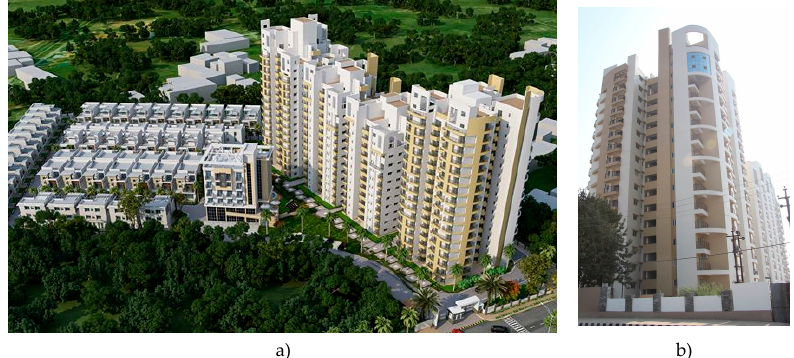
Figure 2. Global overview of the high-rise structure under study: ( a ) location of the houses and the high-rise buildings; and ( b ) front view. The tower is composed by RC frames filled with masonry infill walls made with solid clay bricks aligned according to the longitudinal and transverse direction and two stiff RC cores destined to the elevator boxes. The RC frames are composed by beam-column elements with spans relatively small. The beams are typically composed by two cross-sections, namely 300 x 600 mm and 230 x 600 mm. On the other hand, the columns are composed of 8 types of cross-sections, which are constant in